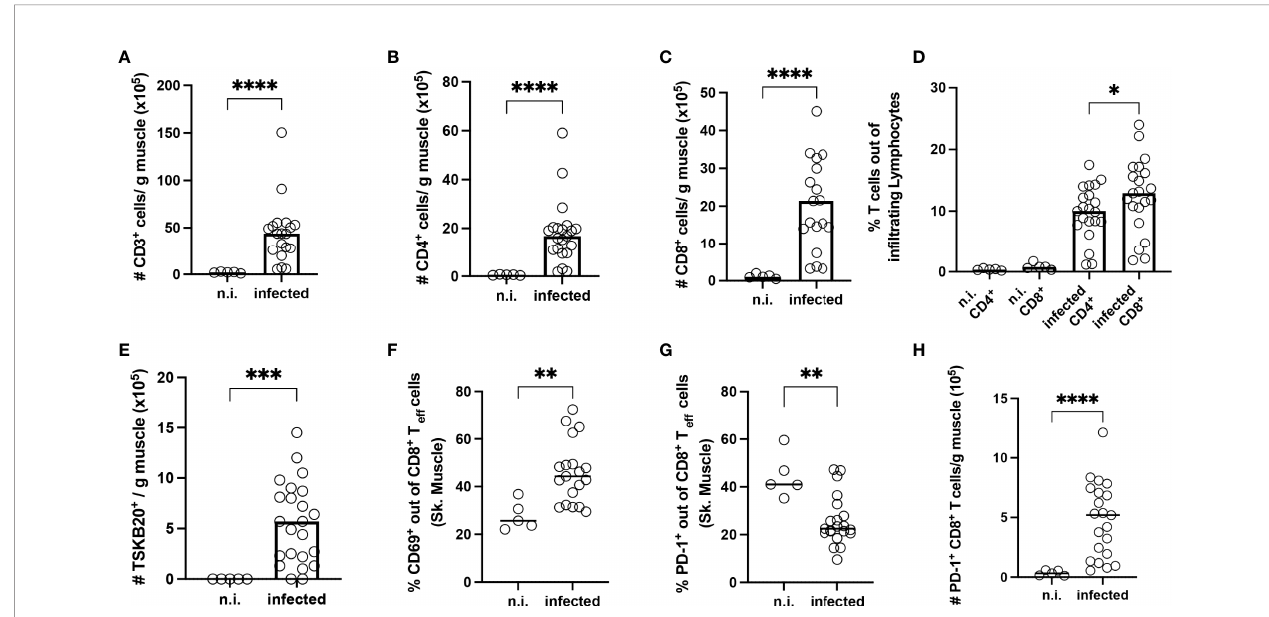
FIGURE 7 | Long-term infection with T. cruzi leads to strong in fi ltration of T cells into the skeletal muscle tissue. T cells were isolated from the skeletal muscle of infected mice at 800 dpi and analyzed by fl ow cytometry. Upper line (A – C) Results expressed as absolute numbers per gram of muscle tissue. (A) CD3 + , (B) CD4 + and (C) CD8 + T cells. (D) Frequency analysis of in fi ltrating T cells. Bottom line (E-H): In absolute numbers (E) TSKB20 + T cells. (F, G) Results expressed as a percentage of effector CD8 + T cells